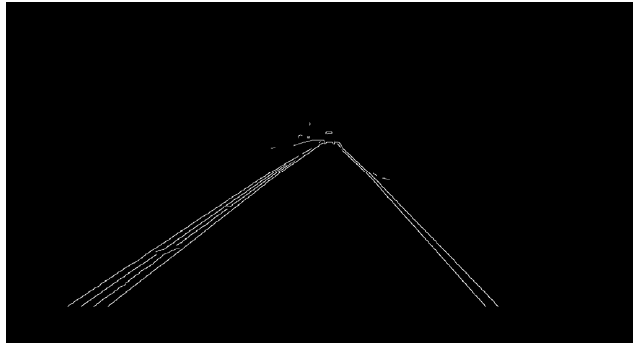
Figure 7. Canny edge detector output masked by a trapezoidal region of interest.